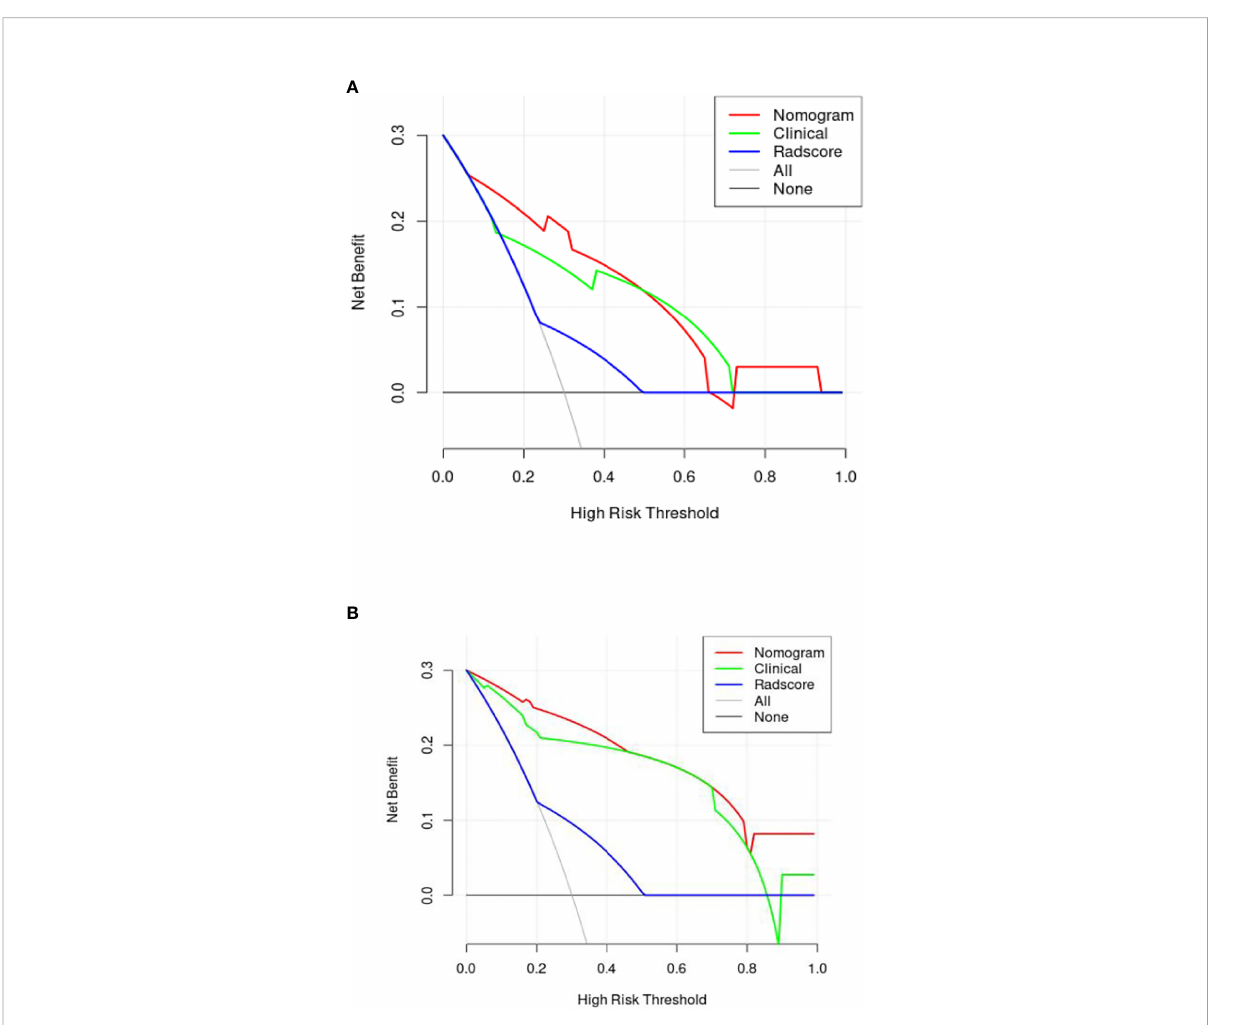
FIGURE 6 The decision curve [ (A) is internal veri fi cation, (B) is external veri fi cation] analysis of the combined nomogram for prediction overall survival in patients with primary nodal Diffuse large B-cell lymphoma. The DCA indicated that the nomogram had a higher diagnostic ef fi ciency than the clinical model and radiomics